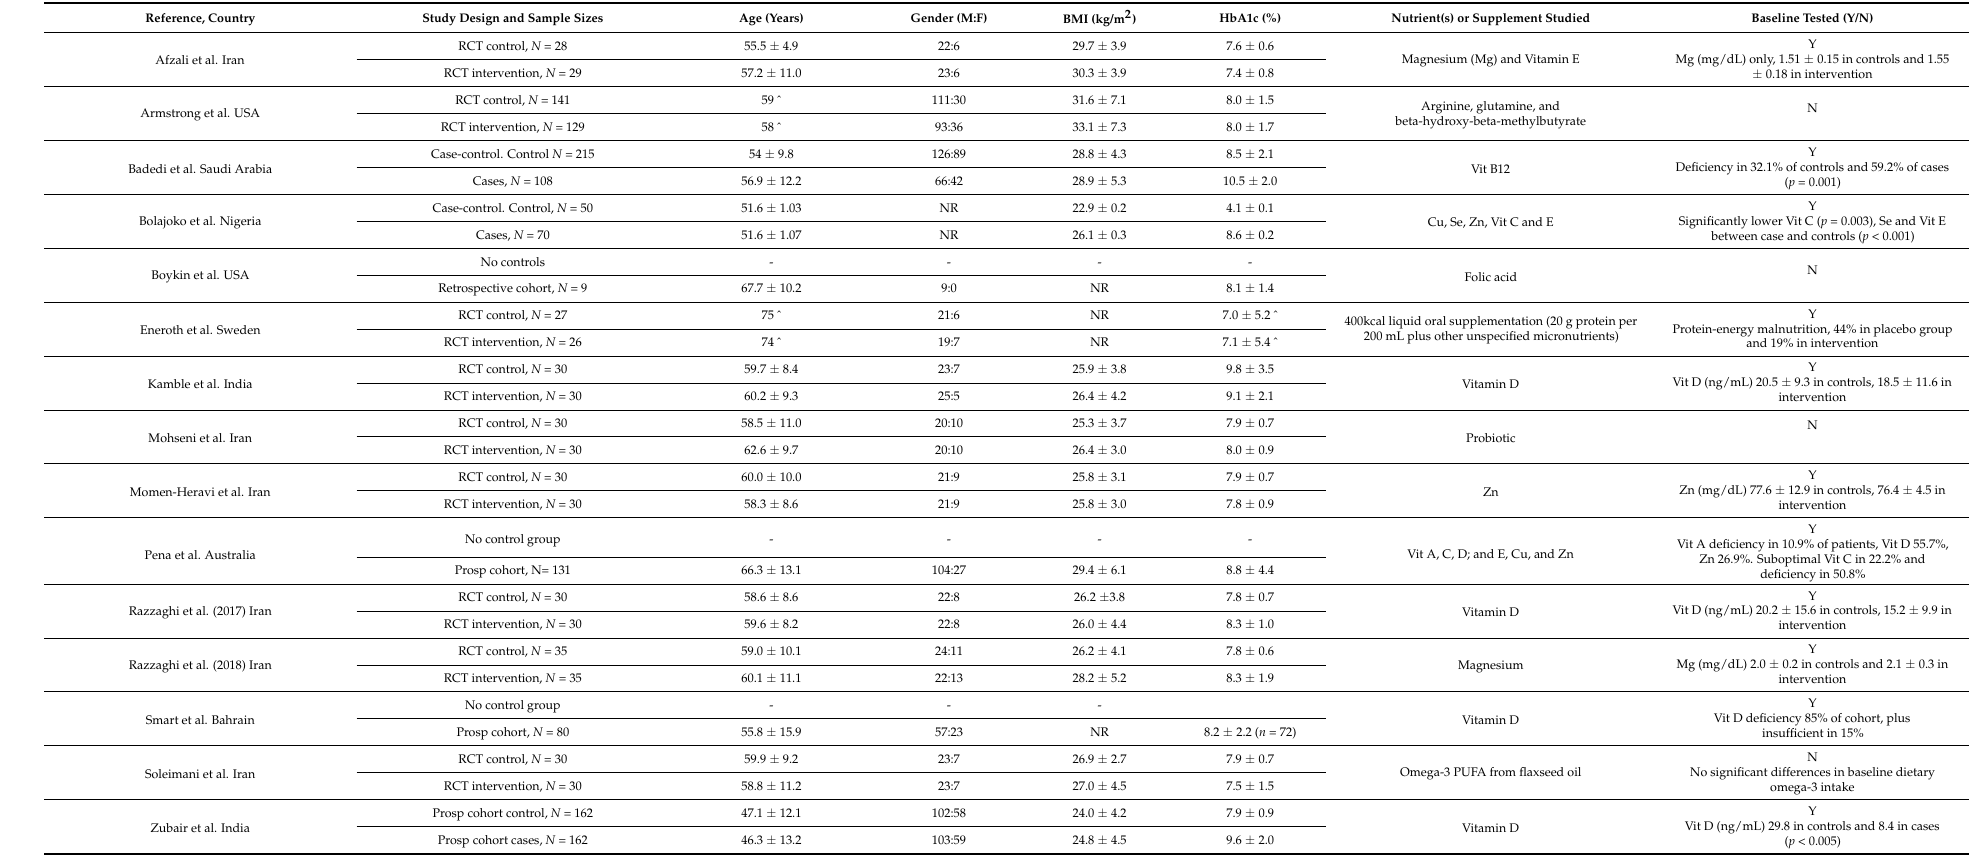
Table 1. Characteristics of the study